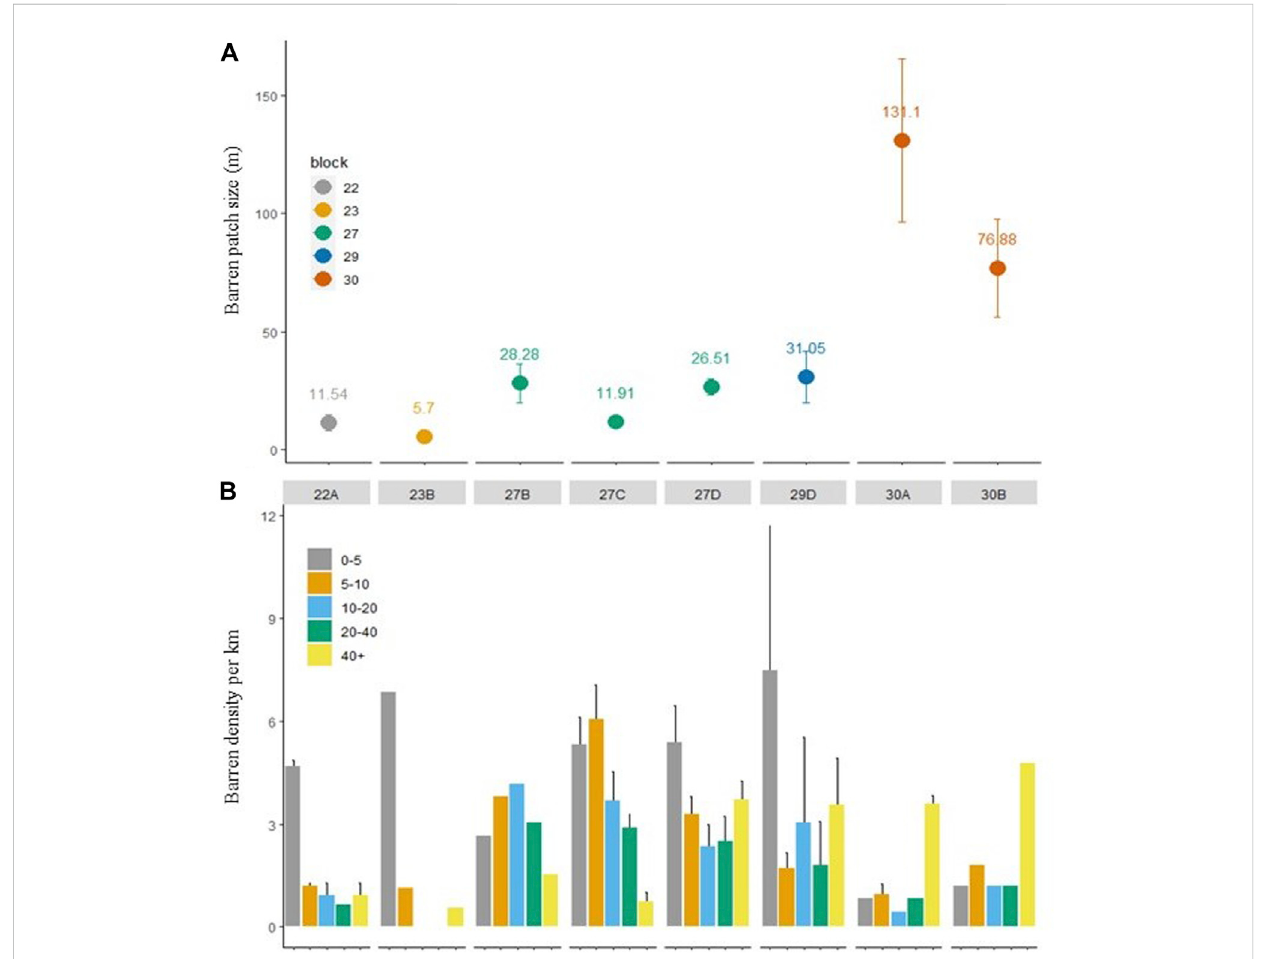
FIGURE 8 Urchin barren patch size and density dynamics. (A) Mean (±SE) of urchin barren patch size (m) based on the length of each barren across abalone management sub-blocks. Numbers above plotted points show the mean patch size in meters. Means and standard errors were generated from the total numberofbarrensrecordedwithineachsubblock. (B) Mean(±SE)densityofurchinbarrens(numberperkilometerofreef)belongingtodifferentsizebins (m) grouped by abalone management sub-block based on video surveys in 2020 – 21. Means and standard errors weregenerated from n = 1 – 5 sites within each